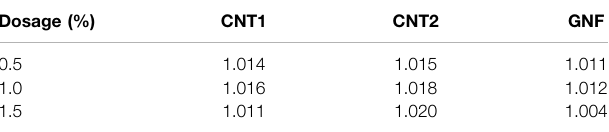
TABLE 4 | Simulated density of different asphalt binders at 25 ° C (Unit: g/cm 3 ). Dosage